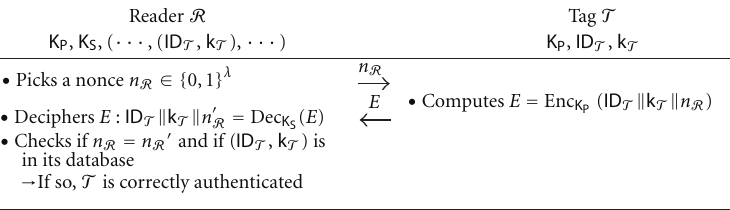
F 5: PK-based authentication